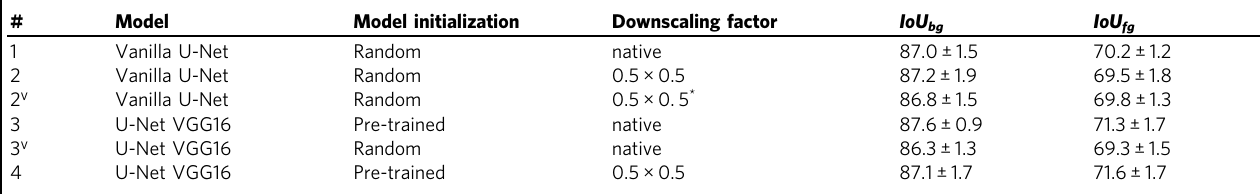
The superscript v indicates a validation experiment conducted to test a particular hypothesis, as described in the section “ Segmentation results ” . The superscript * indicates that downscaling was performed after tiling.